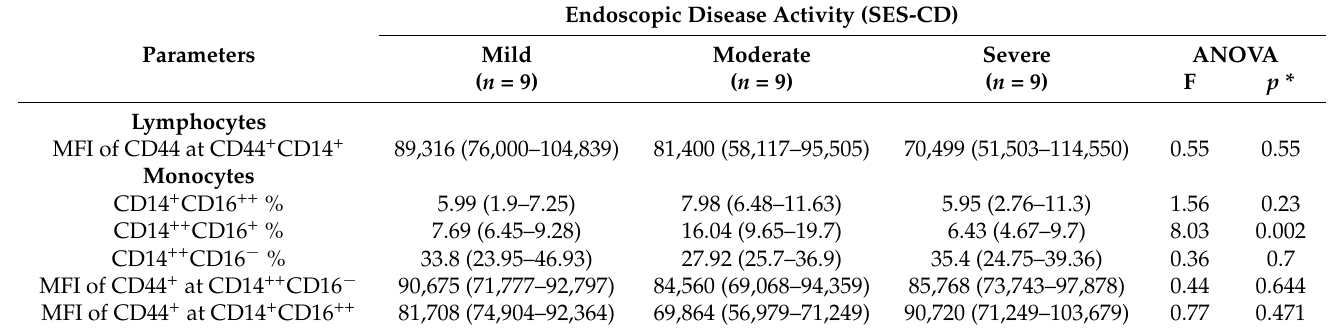
Table 2. Comparison of selected parameters between different disease activity categories in Crohn’s disease patients.